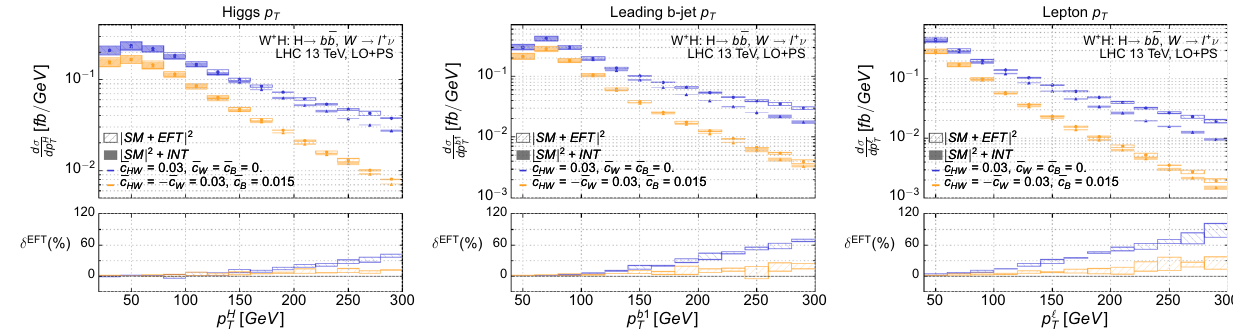
Fig. 2 Selection of W H differential distributions at the LO+PS accuracy in which the EFT squared contributions are either included or not. The results are presented for both benchmark scenarios described in Sect.